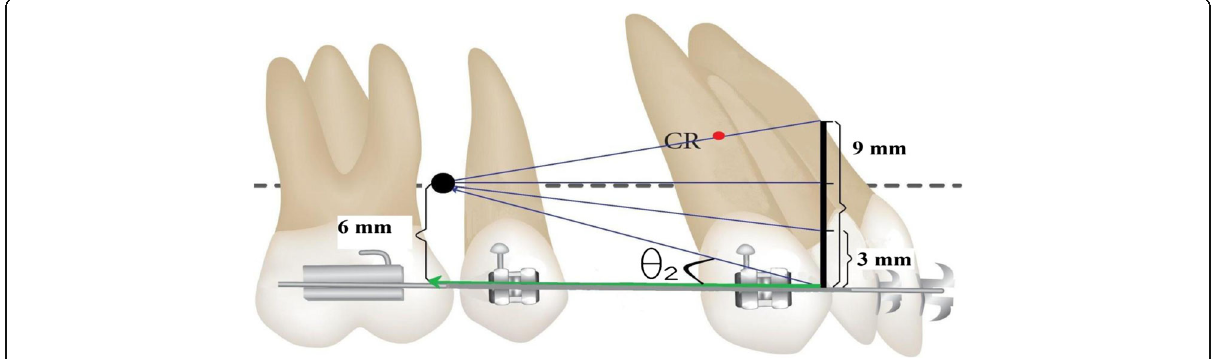
Fig. 4 Schematic force diagram and θ 2 angle in the distal placement of the mini screw ( θ 1 > θ 2